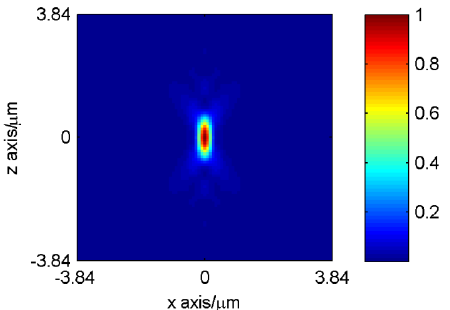
Fig. 5. The point spread function of the detection lens in zx plane.